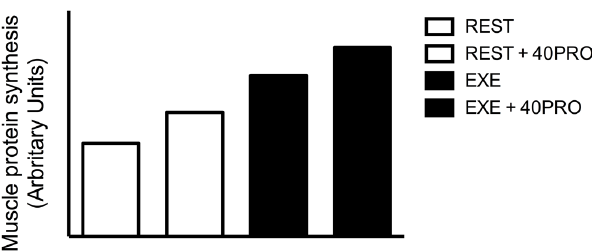
Figure 2. Conceptual framework of the overnight muscle protein synthetic response to 40 g of pre-sleep protein feeding at rest or following prior exercise.